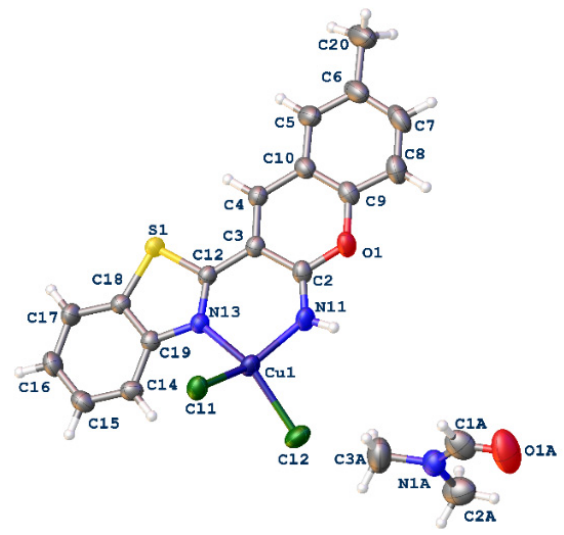
Figure 7. The asymmetric unit of 6c . Displacement ellipsoids are shown at the 50% probability level.